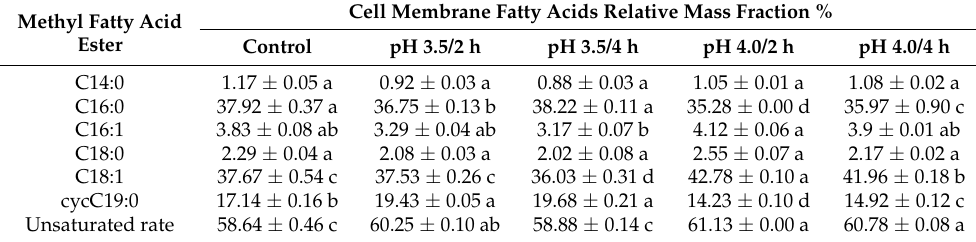
acid stress treatment.